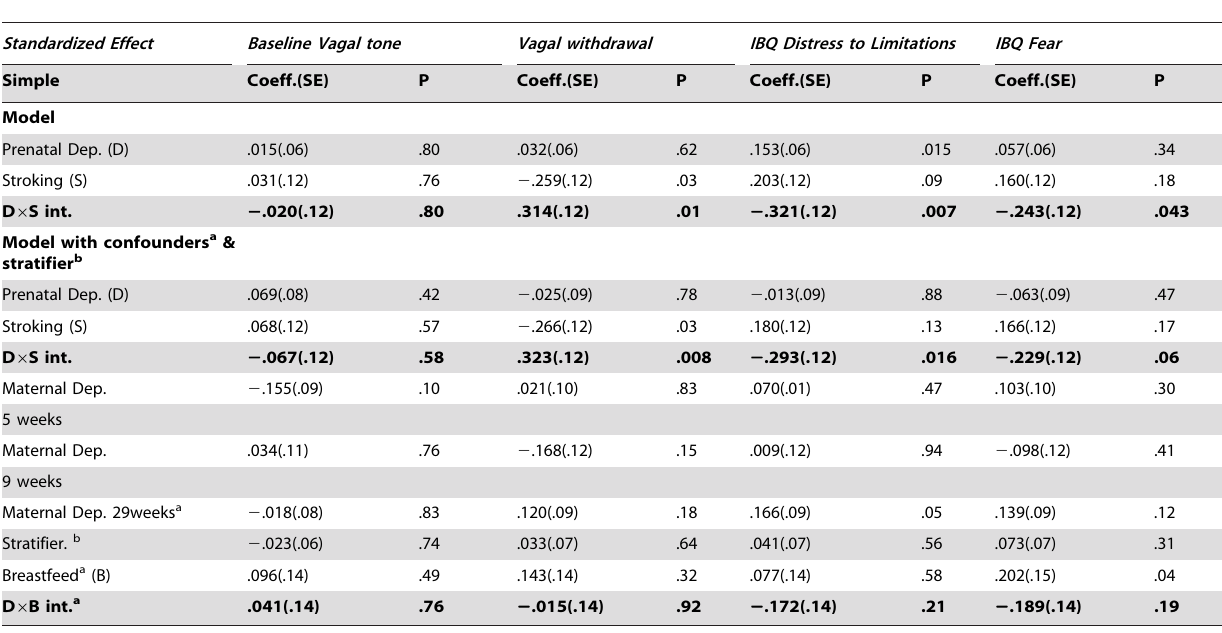
Table 2. Summary of multivariate regression analyses showing coefficients (standard errors) and significance for the effect of maternal report of stroking and prenatal depression with adjustment for sample stratification and 5, 9 and 29 week postnatal depression and breast feeding